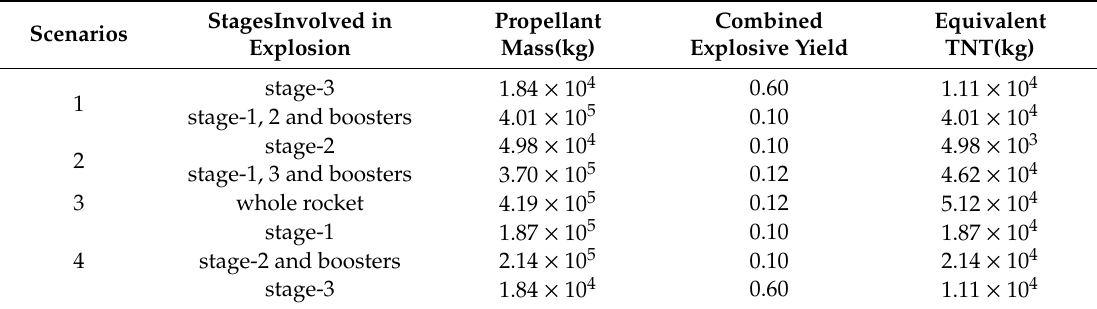
Figure 1. Main size parameters of a certain rocket. Table 5. Parameters for typical scenarios of rocket explosion on launch